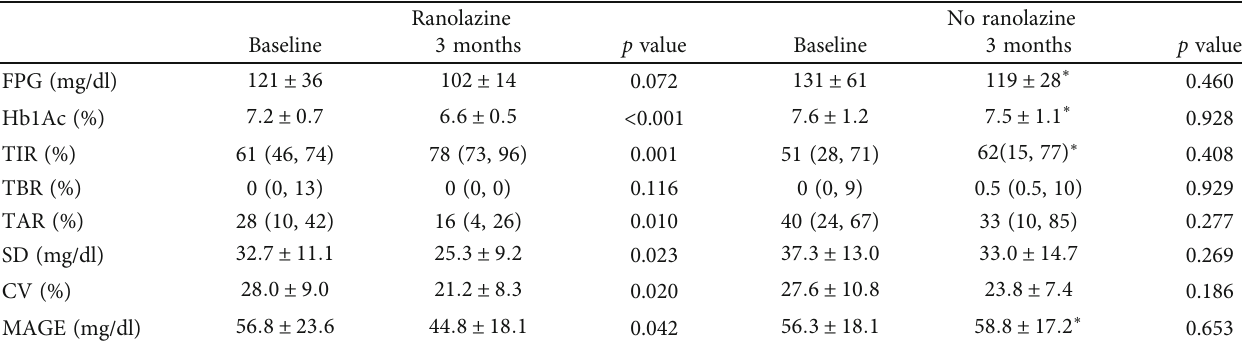
Table 2: Glycemic variability at baseline and after three